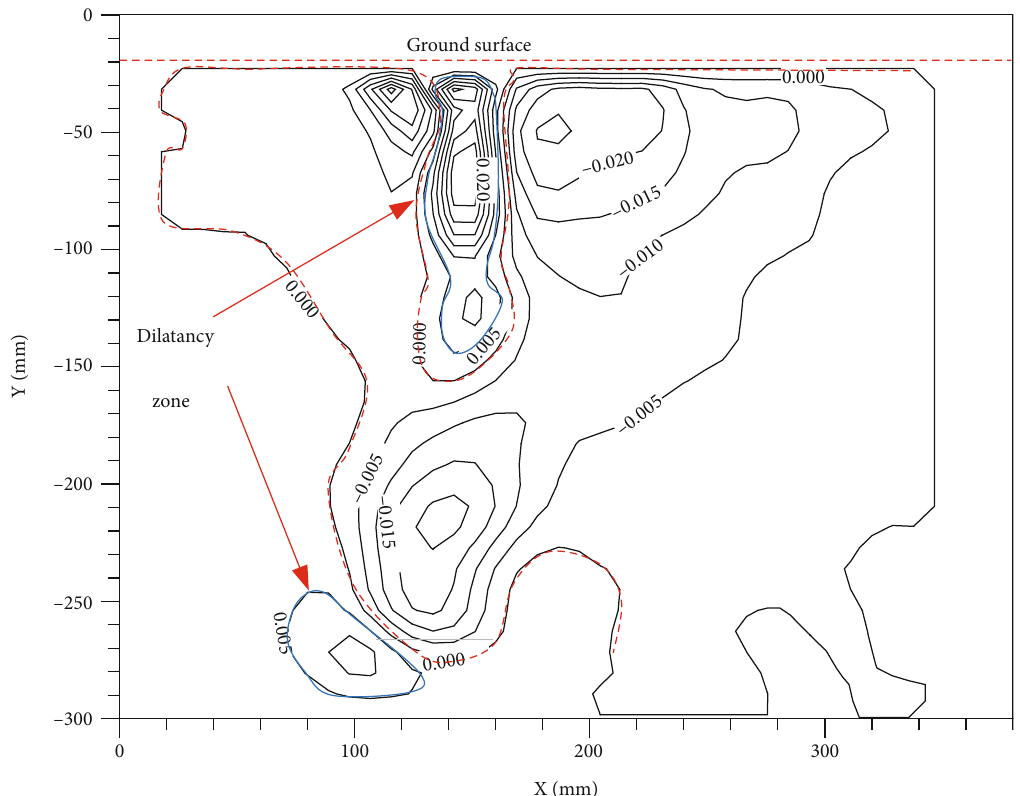
Figure 18: Volume strain fi eld at the ultimate load for D